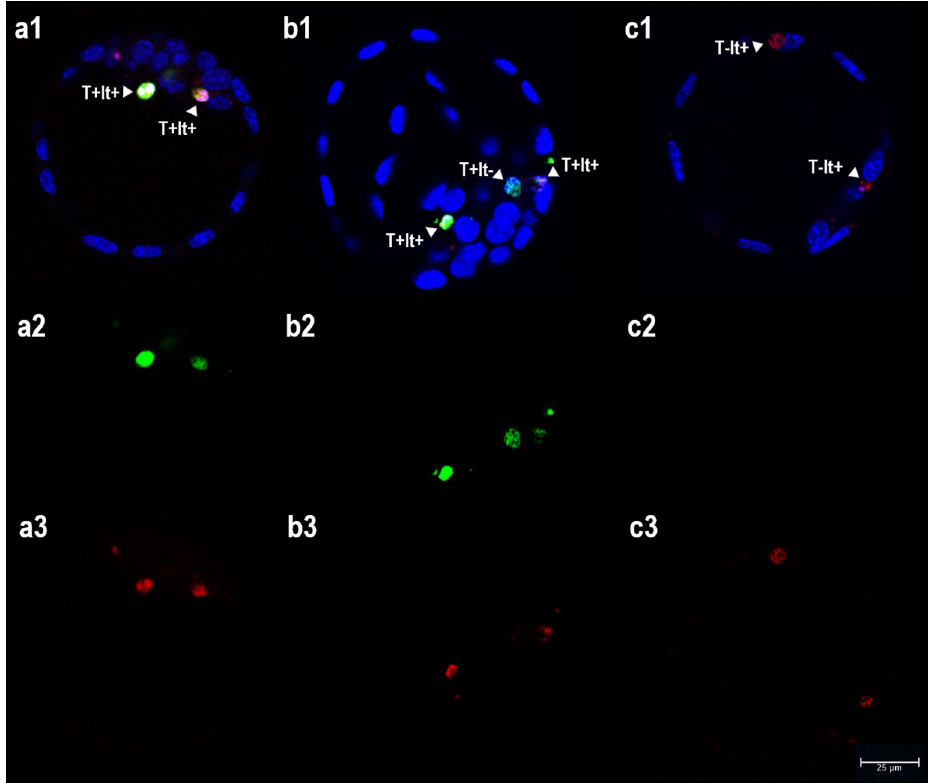
Figure 3. Analysis of acid organelles in mouse blastocysts. Images were obtained by confocal laser scanning microscopy (magnification × 400). Single optical sections of three blastocysts are shown in pictures ( a–c ). To determine the presence of acid organelles (lysosomes/phagosomes) in embryonic cells, LysoTracker labelling was used (lt + = red, a3 – c3 ), combined with TUNEL labelling (T + = green, a2 – c2 ) and Hoechst 33342 DNA staining (blue) ( a1 – c1 : merge). ( a ) Two apoptotic nuclei with condensed chromatin showing co-localization with acid organelles (T + lt+); ( b ) two apoptotic nuclei with condensed/fragmented chromatin showing co-localization with acid organelles (T + lt+) and one TUNEL + nucleus with normal morphology without acid organelles (T + lt−); ( c ) two normal nuclei showing co-localization with acid organelles